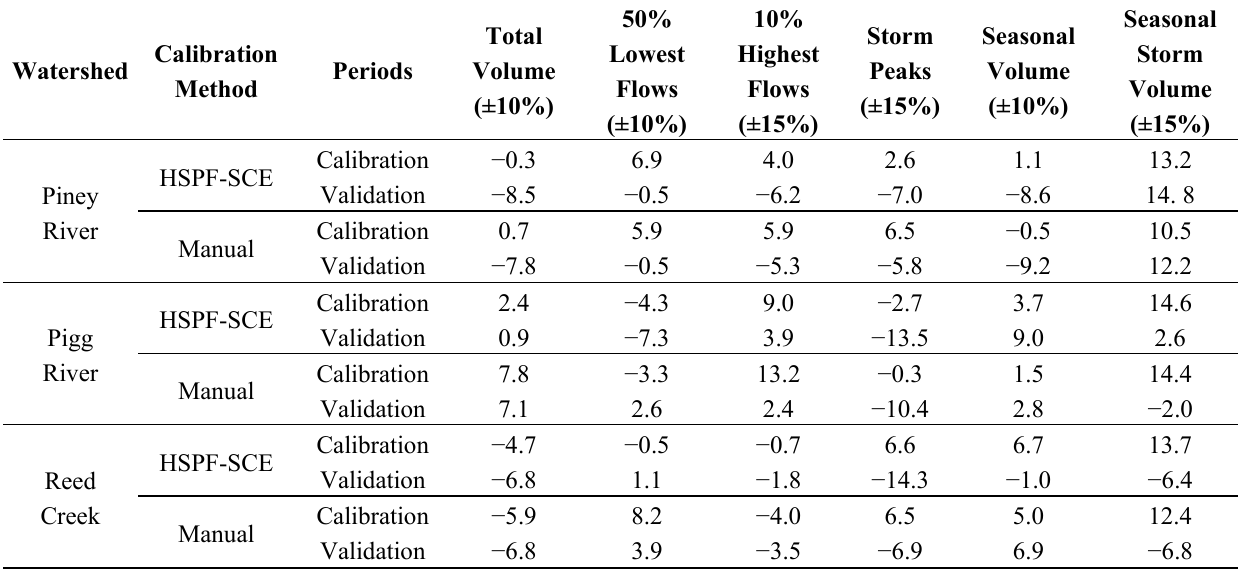
Table 8. Comparison of model performance achieved by the calibrated parameters in terms of the six HSPEXP criteria.